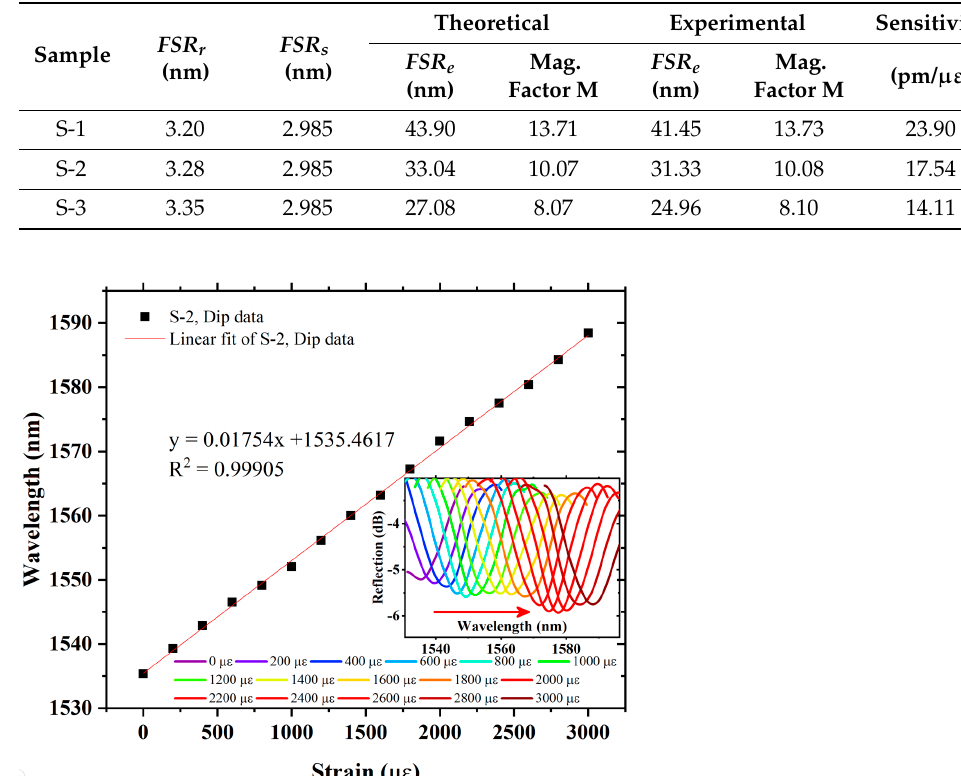
Figure 10. Sensitivity and linear correlation function of S-2, and inset exhibits spectral evolution of envelope dip data.